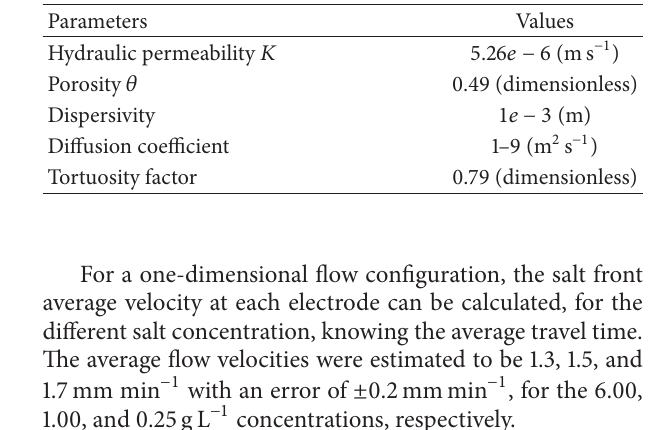
Table 1: Hydrogeophysical input parameter for the